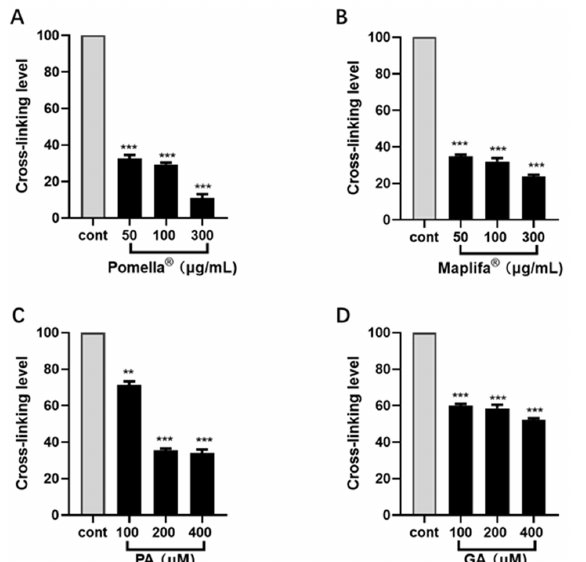
Figure 5. Effects of Pomella ® and Maplifa ® and their respective major phytochemical constituents, namely, punicalagin (PA) and ginnalin A (GA), on the formation of AGEs in a model of type I col-